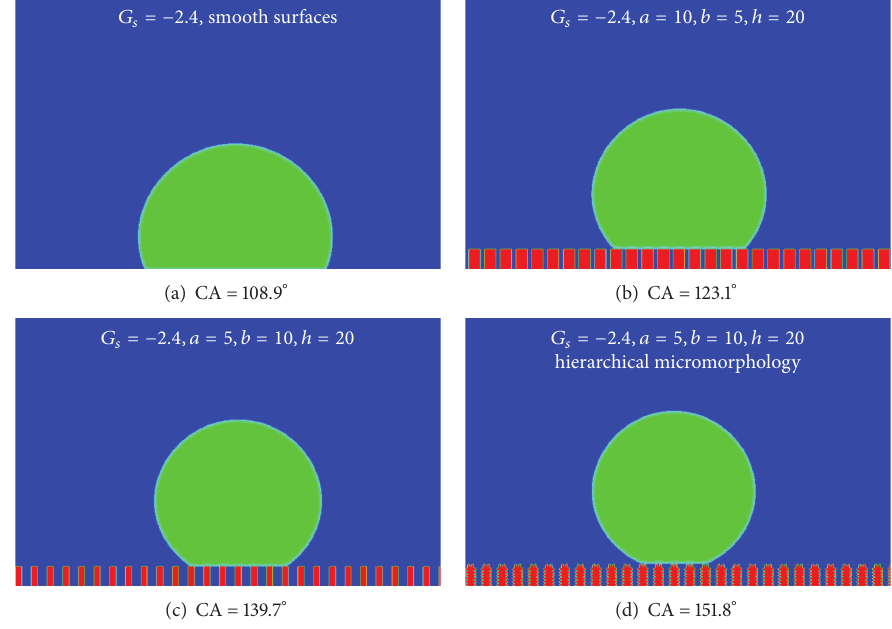
Figure 3: Droplet shape and apparent contact angle of different hydrophobic surfaces. Table 1: The property of hydrophilic and hydrophobic